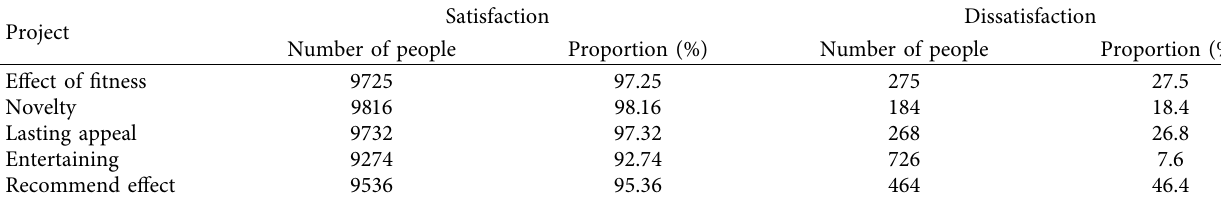
Table 8: Questionnaire survey